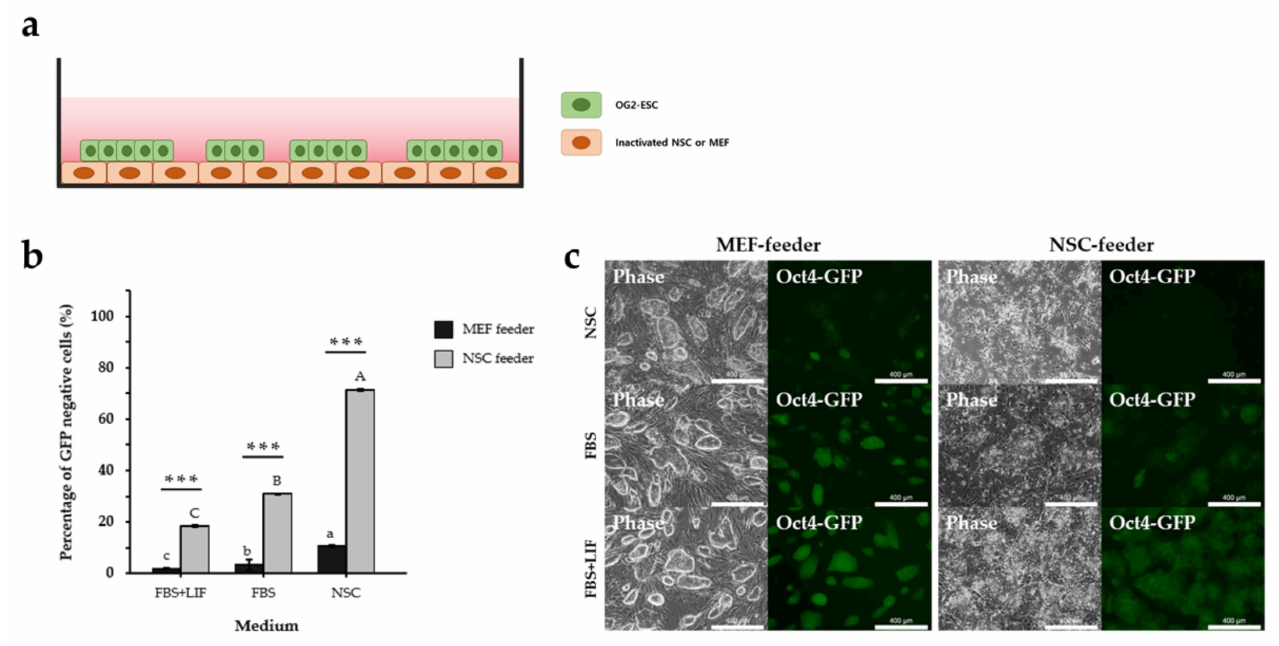
Figure 1. OG2-ESC co-cultured on neural stem cell (NSC)/mouse embryo fibroblast (MEF) feeder under 2D culture conditions. ( a ) Embryonic stem cells grown on inactivated NSC or MEF